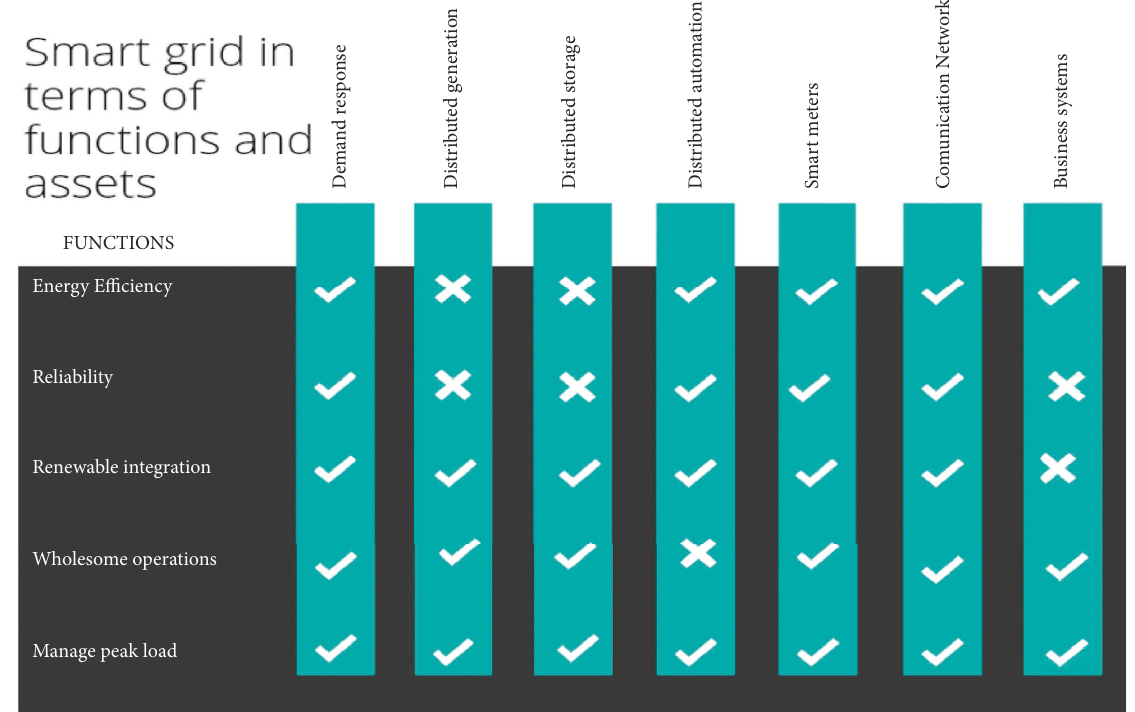
Figure 6: Strengths and qualities of smart